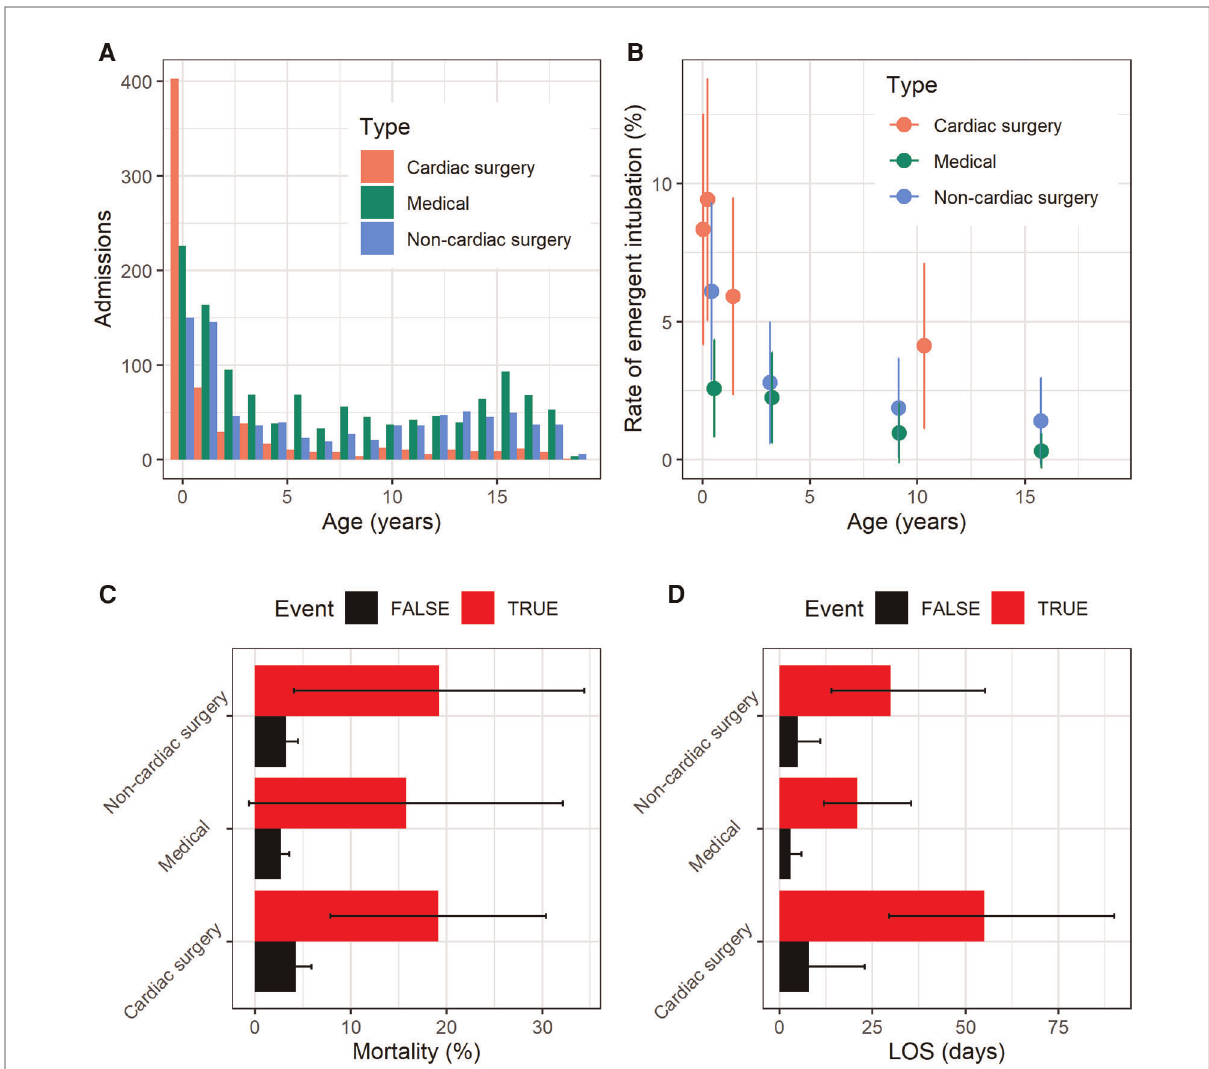
FIGURE 1 Characteristics of the study population. ( A ) Histogram of admissions for each patient type as a function of age. ( B ) Rate of unplanned intubation for each patient type as a function of age. ( C ) Mortality rate for each patient type with (red) and without (black) unplanned intubation. Error bars are 95% con fi dence interval. ( D ) Median length of stay in days for each patient type with (red) and without (black) unplanned intubation. Error bars show the